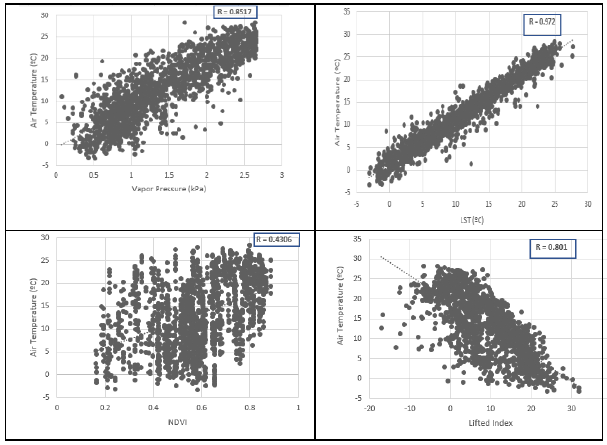
Figure 4. Scatterplots of air temperature Vs different